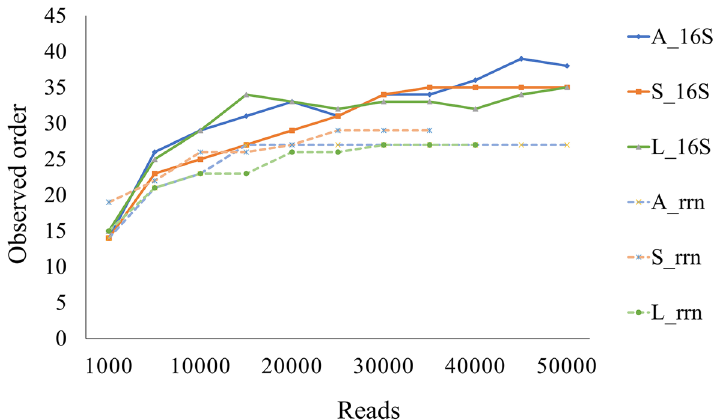
Figure 3. Numbers of observed orders against numbers of sequence reads. Three equine fecal samples (A, S, and L) were subjected to full-length 16S rRNA gene amplicon sequencing (16S) and rRNA operon amplicon sequencing